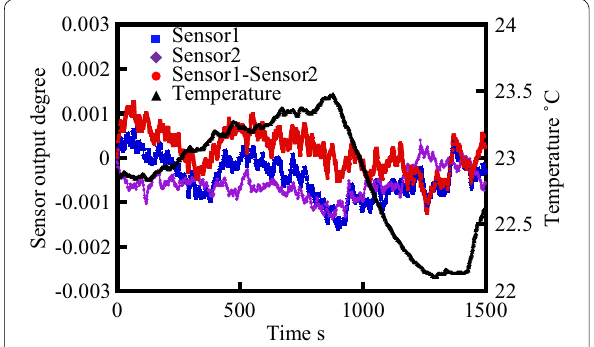
Figure 12 Stability of the sensor